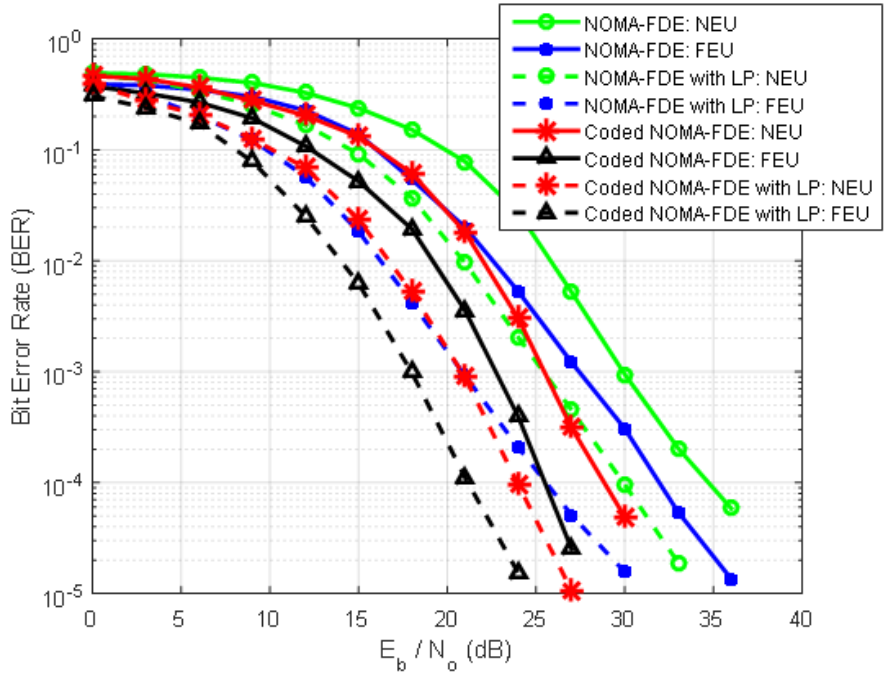
Figure 17. BER comparison of un-coded MC-NOMA and coded MC-NOMA with and without WHT in the presence of AWGN